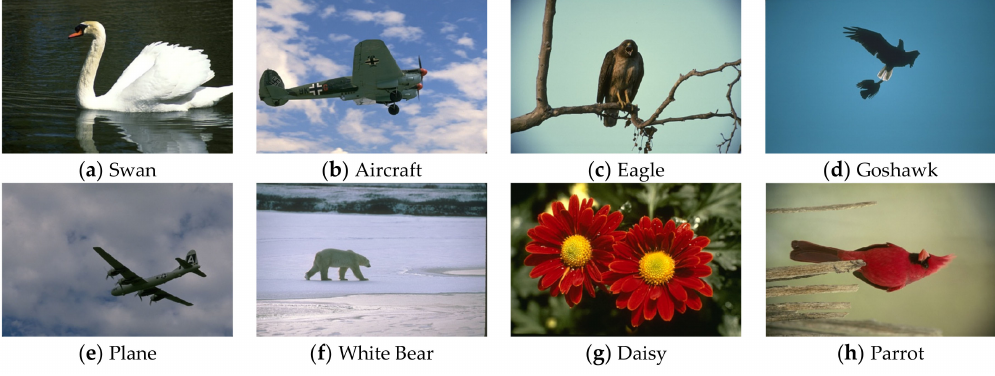
Figure 7. Eight tested images.